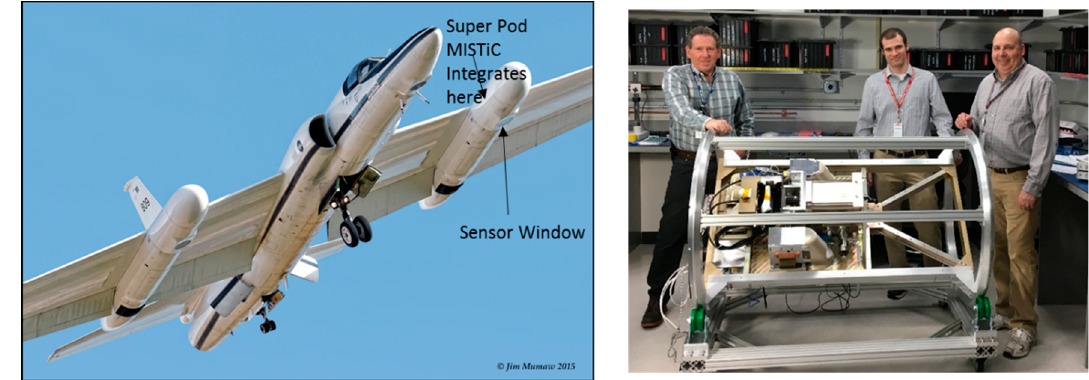
Figure A2. NASA ER2 Platform ( right ), and MISTiC airborne demonstration instrument ( left ).